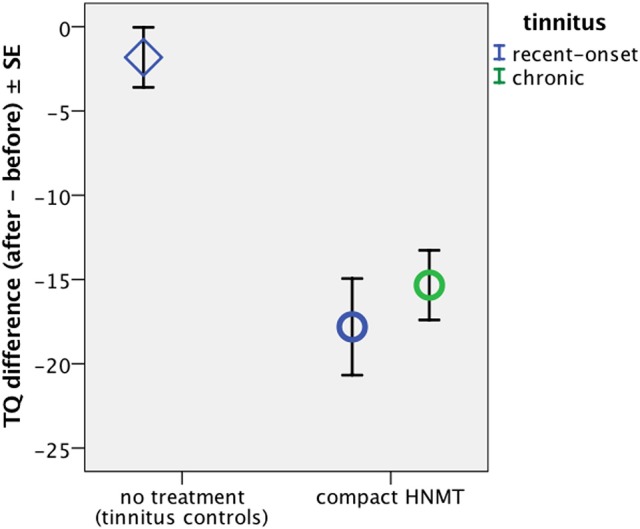
Change in subjective tinnitus distress as measured by TQ. Krick et al. (2015) found that HNMT caused a major improvement in tinnitus distress in recent-onset tinnitus patients (blue circle), as measured by a reduction of near 18 on the TQ scale, an improvement which was not observed in non-treated passive control patients (rhomb). Here we measured the HNMT effect in chronic tinnitus sufferers (green circle), revealing a similar decrease on the TQ score by 15.3 ± SD 9.5 (n = 21; Z = −4.3; p < 0.0001). There was no significant difference in the therapy-induced TQ reduction between treated chronic and treated recent-onset patients (n = 21/21; Z = −0.4; p > 0.6).